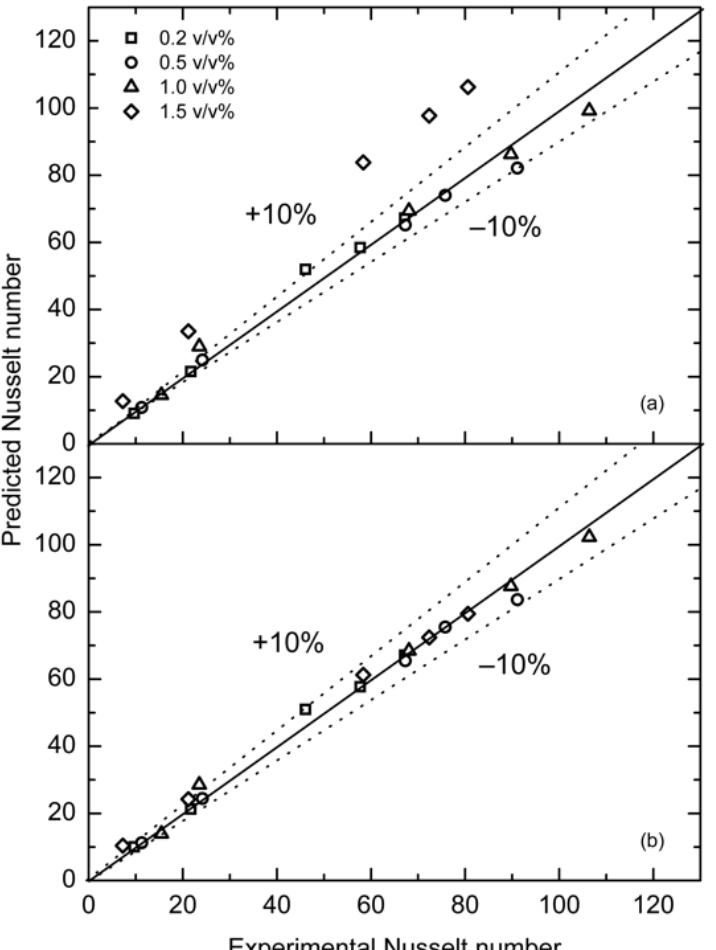
Figure 11. Deviation between the experimental and predicted N Nu values of TiO 2 –W flows. The predicted values were obtained by the proposed empirical correlations: Equation (12) in ( a ) and Equation (13) in ( b